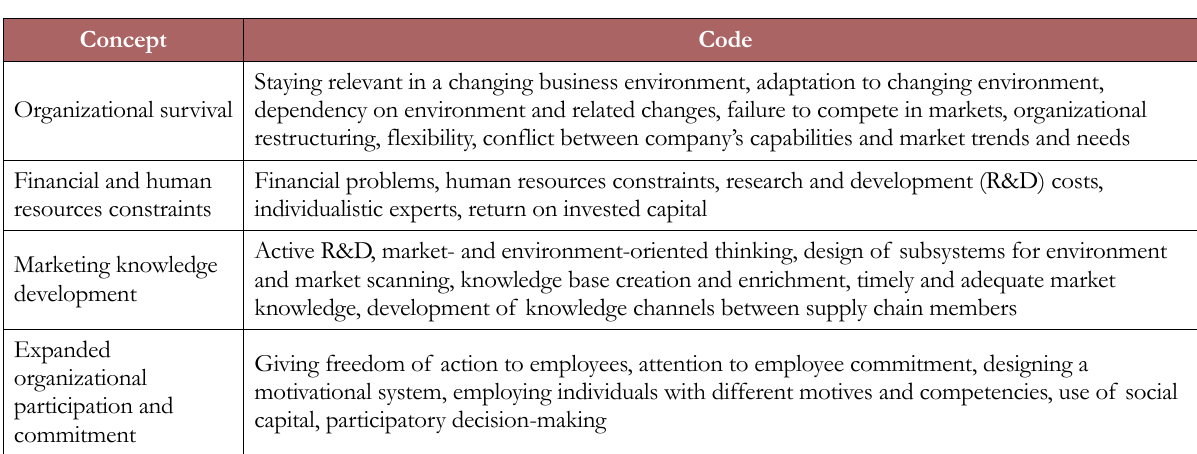
Table 2. Examples of open coding